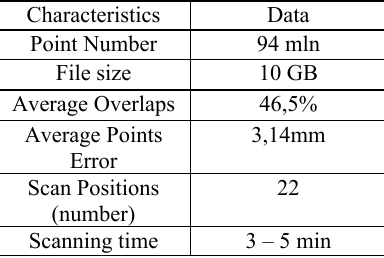
Table 2. Data Report from the survey in standard condition